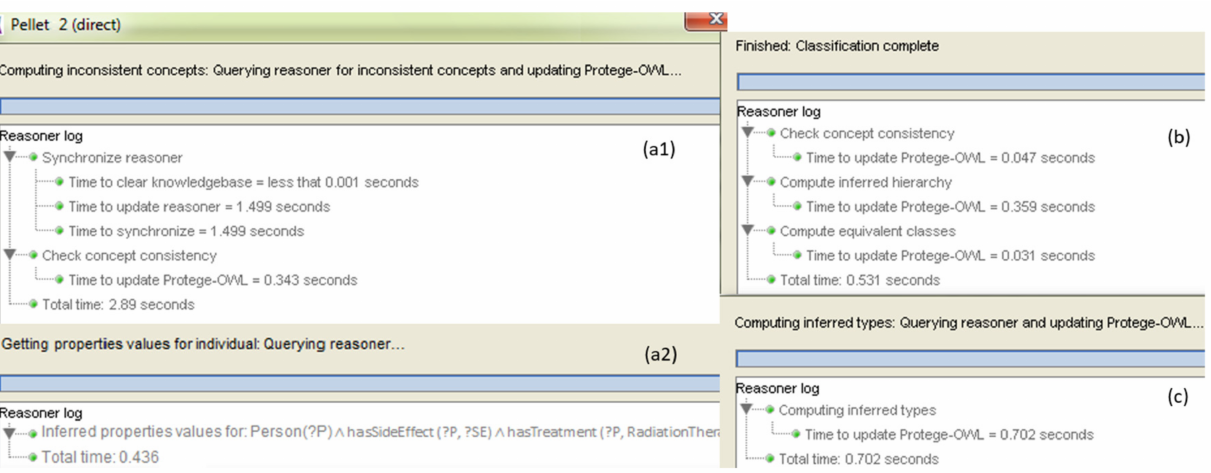
Figure 5. Checking the consistency of the classes ( a1 ) and their properties ( a2 ), the taxonomy ( b ) and the inference ( c ) within the model through Pellet reasoner